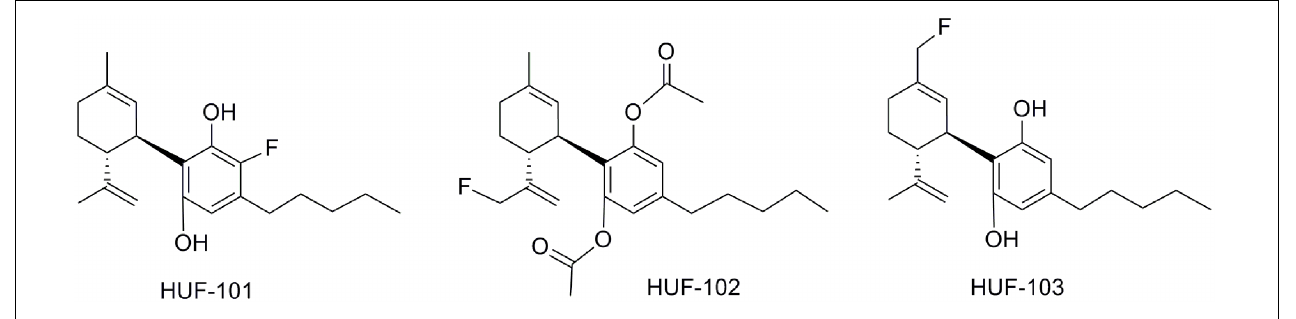
FIGURE 10 | Fluorinated CBD derivatives.